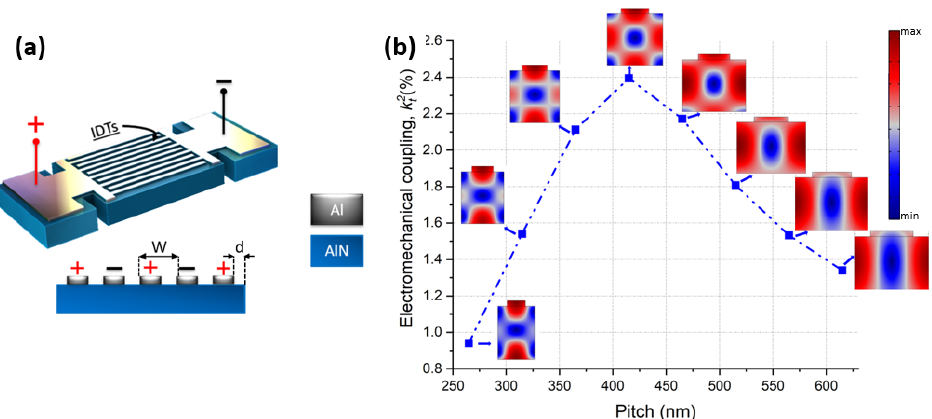
Figure 1. ( a ) CLMR geometry in 3D. ( b ) Simulated k t 2 over a range of pitch values with corresponding mode shapes.